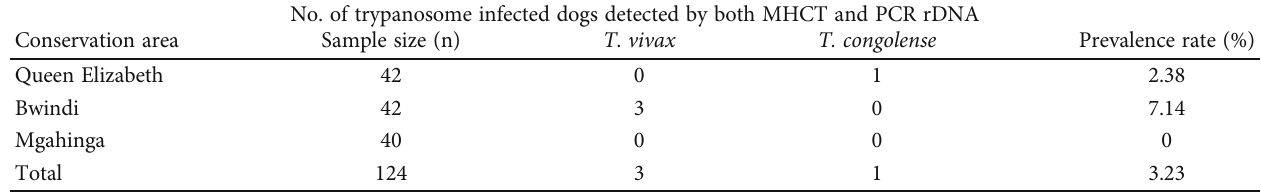
Table 2: CAT prevalence rate (%) in relation to age in the three conservation areas. Conservation area